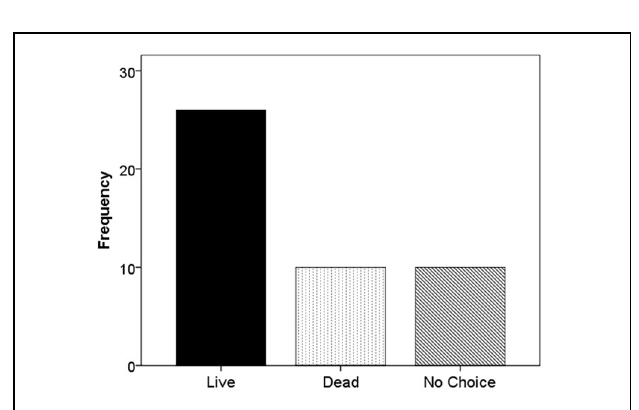
FIGURE 5 | Frequency of selection of extending stolons between live substrate ( (cid:2) ), sand ( ), or no choice ( ).